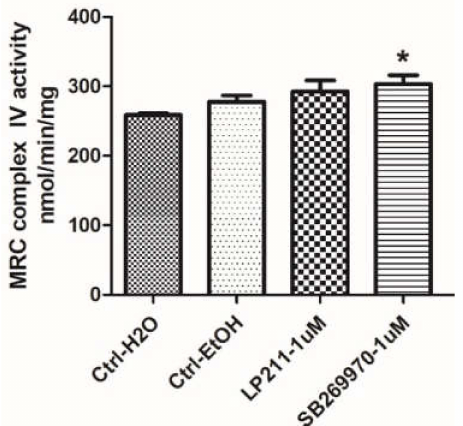
Figure 3. SB-269970 showed a weak stimulating e ff ect on cytochrome c oxidase activity, which was spectrophotometrically measured in mitochondrial fractions from SH-SY5Y cells administered with LP-211 and SB-269970 3 min before measurements. Values represent mean rates (nmol / min / mg) ± SEM obtained from at least four independent experiments. * p < 0.05, nonparametric Wilcoxon test between mitochondria administered with SB-269970 and nontreated mitochondria in two controls. Ctrl-EtOH, 10% EtOH in H 2